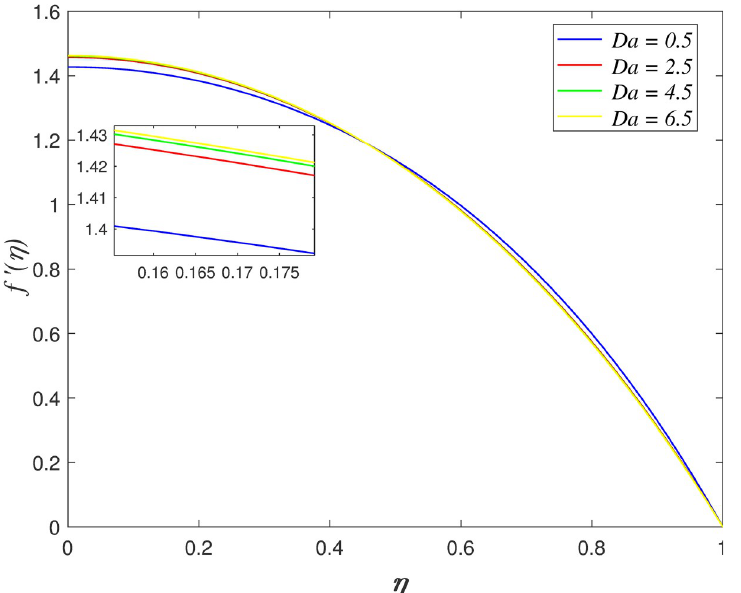
Fig 14. Impact of Da on axial velocity.